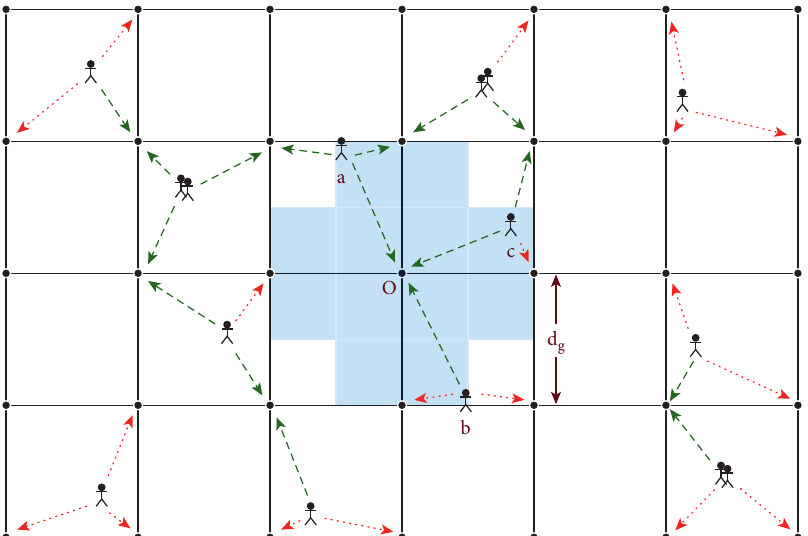
Figure 13: Possible options of demand consolidation at virtual stops. (For the interpretation of the references to colour in this figure legend, the reader is referred to the web version of this article.).